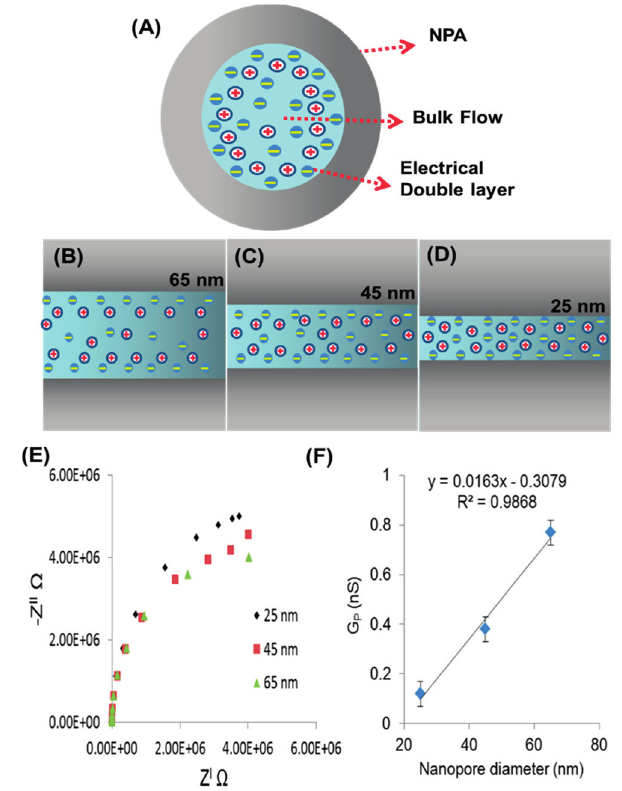
Figure 4. Schematic presentation for formation of electrical double layer and bulk flow